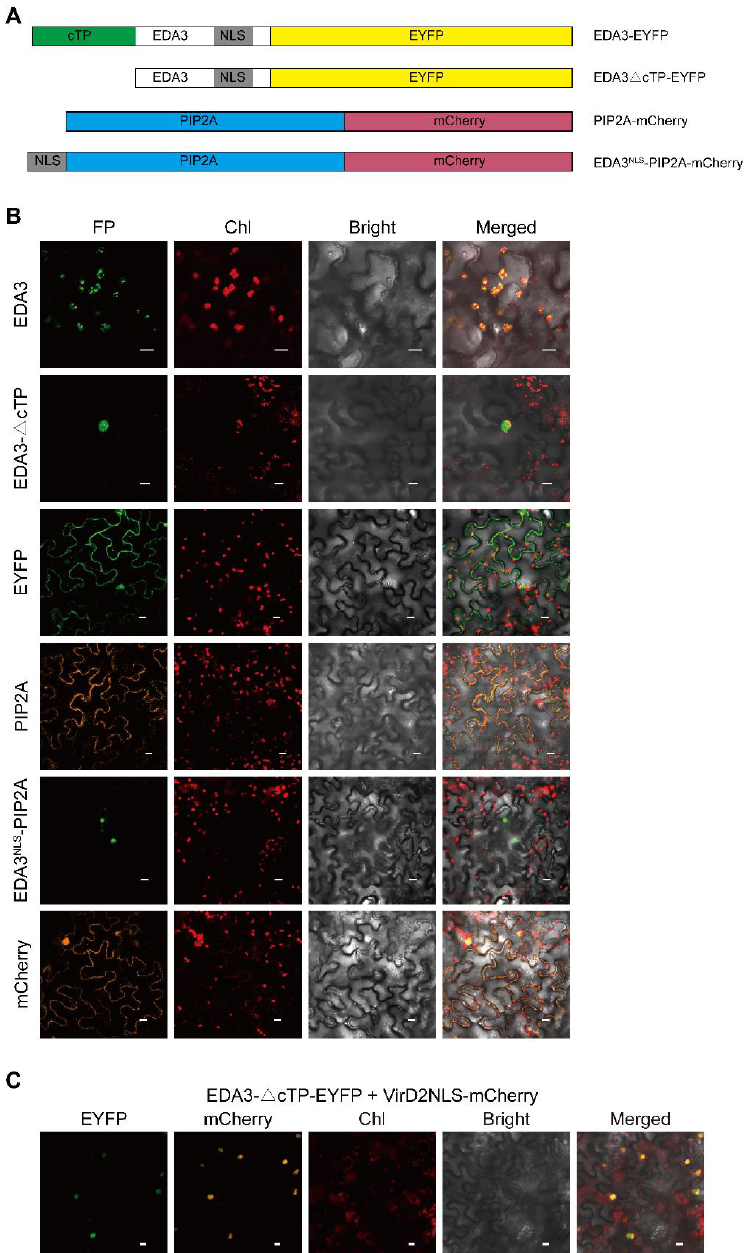
Figure 4. The nuclear localization signal (NLS) of EDA3 accounts for its nuclear targeting. ( A ) Schemes of the fusion proteins used in this assay. NLS, nuclear localization signal; cTP, chloroplast transit peptide; EDA3 ∆ cTP, truncated EDA3 with its cTP removed; EDA3 NLS -PIP2A, PIP2A protein fused beyond the NLS of EDA3. The CaMV 35S promoter was used to drive the transient expression of each protein in tobacco leaves; ( B ) Transient expression EDA3 and EDA3 ∆ cTP fused upstream EYFP, and PIP2 and EDA3 NLS -PIP2A fused upstream mCherry, in tobacco leaves by infiltration; ( C ) Co-localization of the EDA3 ∆ cTP-EYFP fusion protein with the nuclear localization marker protein VirD2NLS-mCherry. The excitation wavelengths for EYFP, mCherry, and chlorophyll auto-fluorescence were 488, 543, and 543 nm laser, respectively, and their corresponding recoding ranges were 500–530, 580–620, and 680–720 nm, respectively. Empty vectors expressing EYFP and mCherry were used as controls. FP, fluorescent protein. Bar = 10 µ